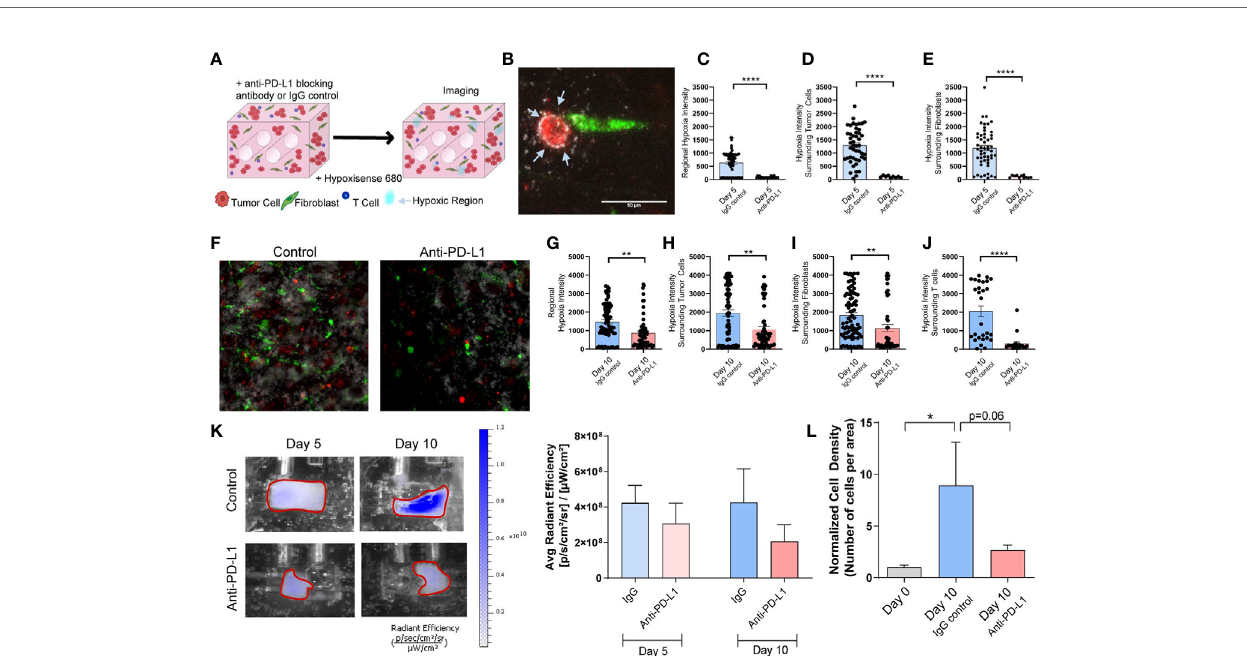
FIGURE 7 | Immune Checkpoint Blockade Impacts Regional Hypoxia within Tumor Mimics (A) Schematic showing tumor mimics containing tumor cells (red), fi broblasts (green) and T cells (blue) which are treated with anti-PD-L1 blocking antibody or IgG control and undergo hypoxia analysis using a probe for carbonic anhydrase IX (Hypoxisense 680). (B) Representative confocal image showing tumor cell (red) and fi broblast (green) with carbonic anhydrase IX positive region (white) around the tumor cell. (C) Measurement of regional hypoxia within confocal images shows a decrease in the average intensity of hypoxic regions, indicating decreased hypoxia with anti-PD-L1 treatment on day 5 of culture. n=23-62 regions per condition. (D, E) Measurement of hypoxic regions surrounding cells within confocal images shows a decrease hypoxia surrounding tumor cells (D) and fi broblasts (E) with anti-PD-L1 treatment on day 5 of culture. n=9-52 regions per condition. (F) Representative confocal image showing decreased carbonic anhydrase IX signal within the anti-PD-L1 treated tumor mimic following 10 days culture. (G) Measurement of regional hypoxia within confocal images shows a decreased hypoxia with anti-PD-L1 treatment on day 10 of culture. n=58-74 regions per condition. (H – J) Measurement of hypoxic regions surrounding cells within confocal images shows a decrease hypoxia surrounding tumor cells (H) , fi broblasts (I) , and T cells (J) with anti-PD-L1 treatment on day 5 of culture. n=20-86 regions per condition. (K) Left: IVIS imaging of carbonic anhydrase IX probe, Hypoxisense 680,